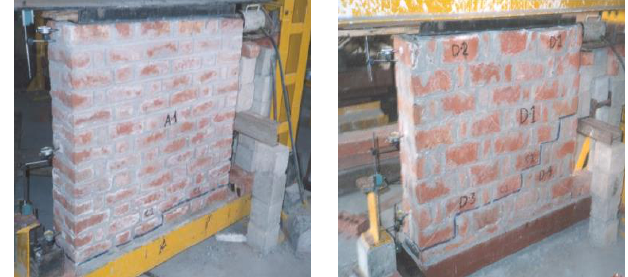
Fig. 4. Failure Pattern of RTB (left) and English bond (right) [23]